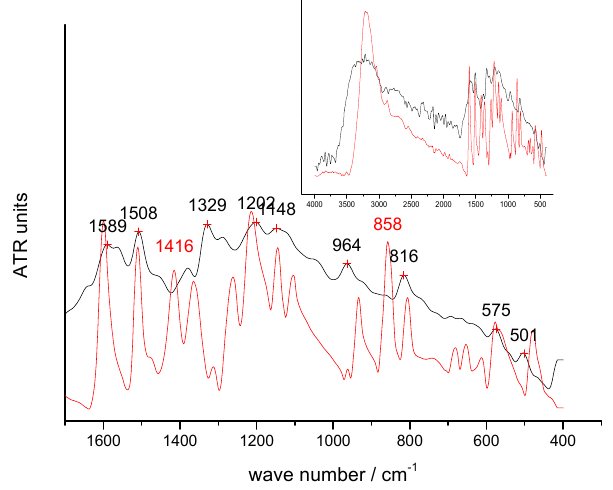
Figure 4. FTIR-ATR spectra for monomer 2,6-DHN (red line) and poly(2,6-DHN)/SPCE (black line).